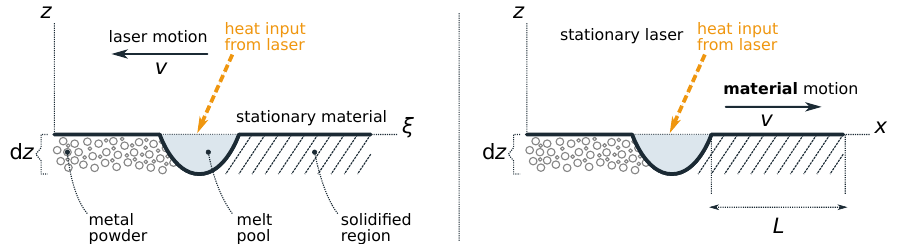
Figure 2. Problem setup for printing one line of metal. ( Left ): In the ξ frame, the laser scans toward the left, at a constant speed v , over a stationary material. The effects of the scan angle are ignored, approximating the scan as linear motion. ( Right ): The setup used in the analysis. In the x frame, the material moves toward the right, at the same constant speed v , under a stationary laser. We consider a length L of the axially moving material, starting from the trailing edge of the melt pool, where the material has just